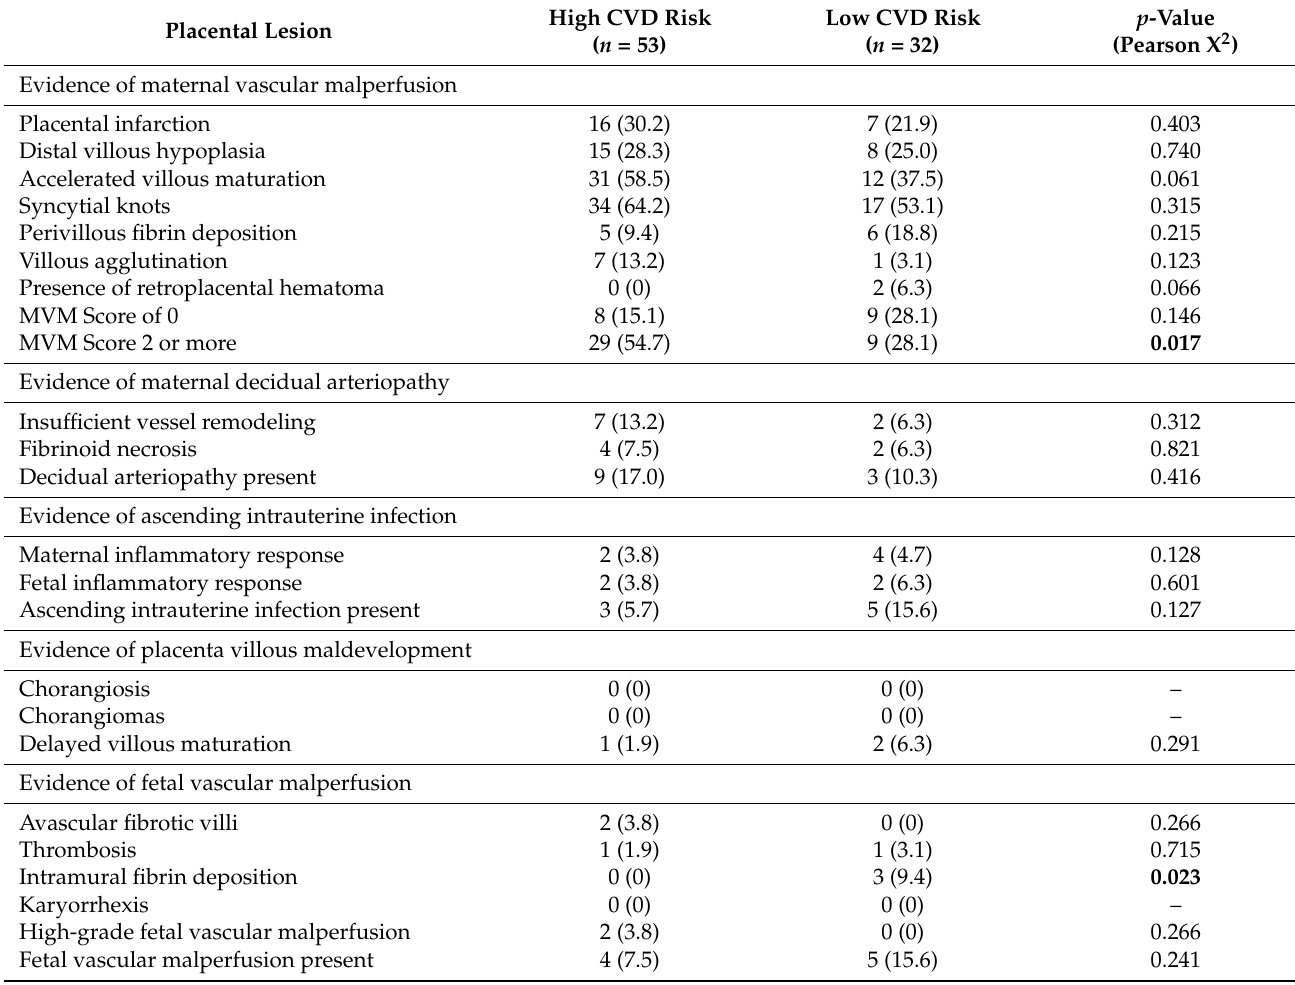
Table 3. Frequency of placental lesions by cardiovascular risk